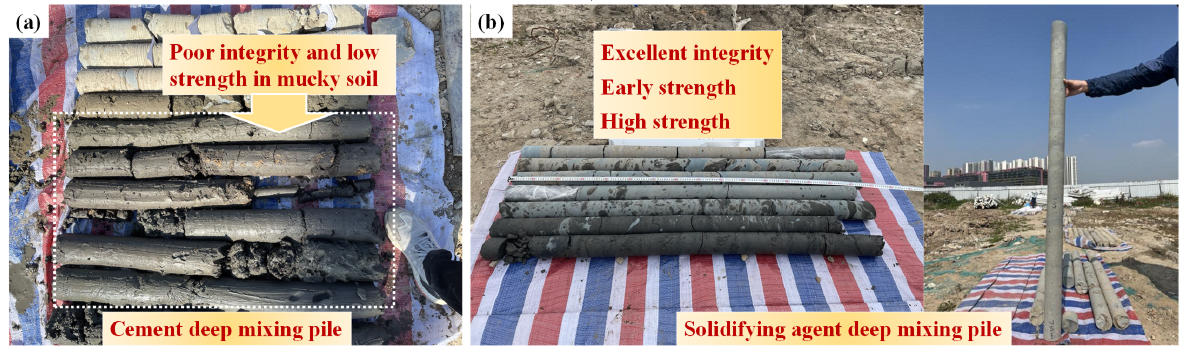
Figure 4. Integrity of different types of solidifying materials in deep mixing piles: ( a ) cement and ( b ) solidifying agent.